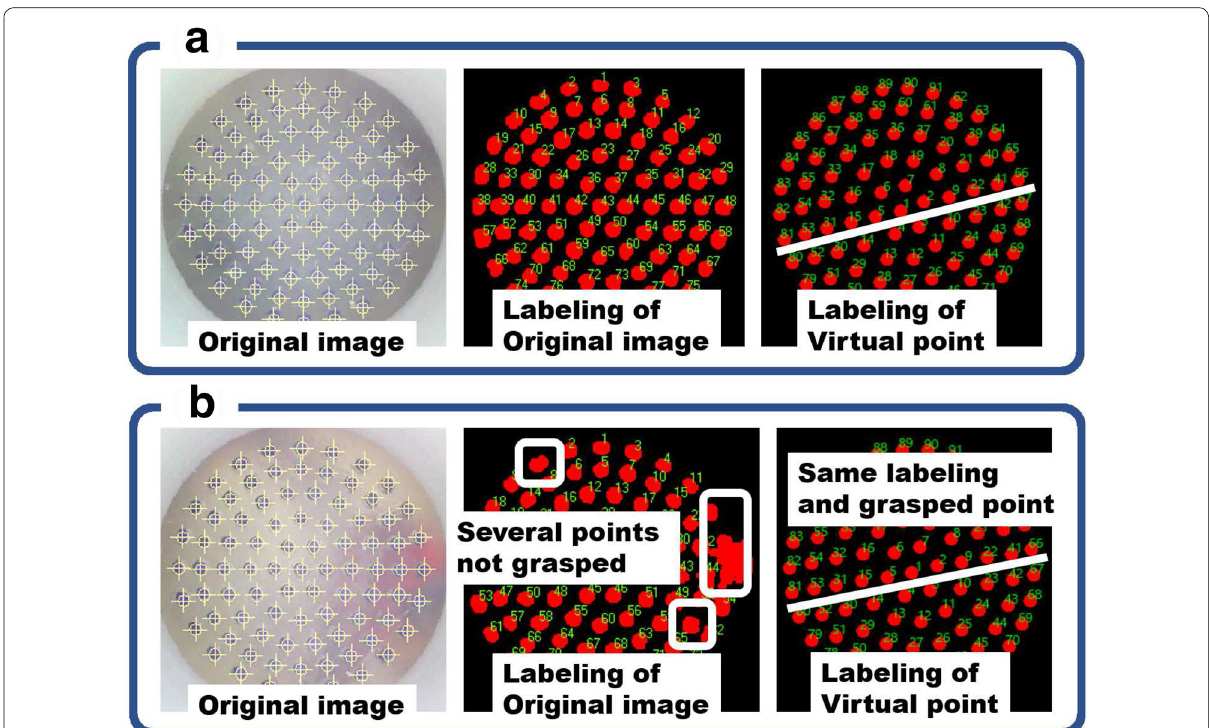
Fig. 6 Labeling by external environment and virtual points: a In case there is no influence on the external environment. b In case the external environment affects the marker. Markers may not be observed if the external environment is different. These changes in the environment can also be observed using virtual